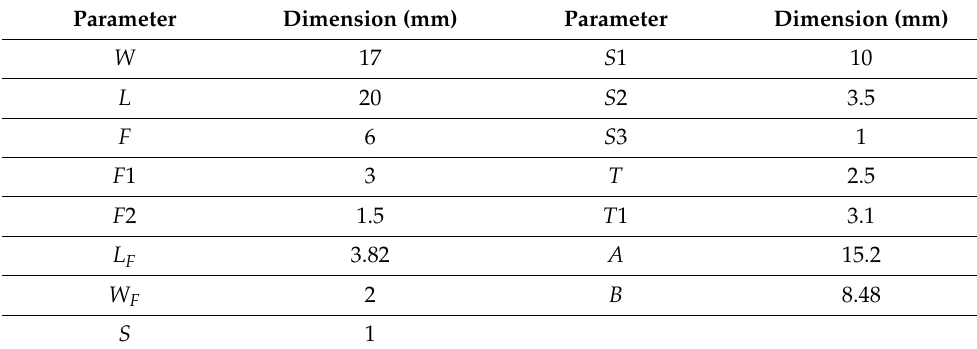
Table 1. Dimensions of the proposed UWB antenna.